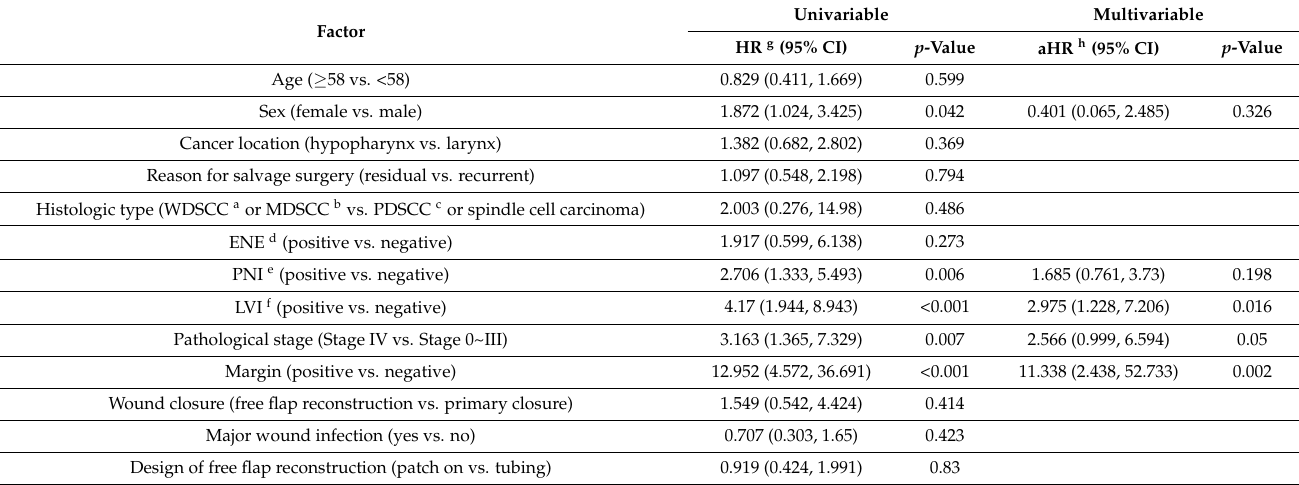
Table 3. Univariable and multivariable Cox analysis of prognostic factors associated with disease-specific survival.